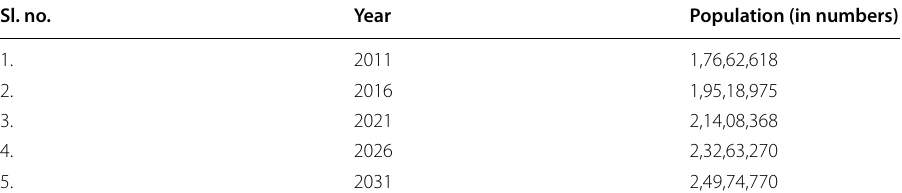
Table 9 Projected population Sl. no.